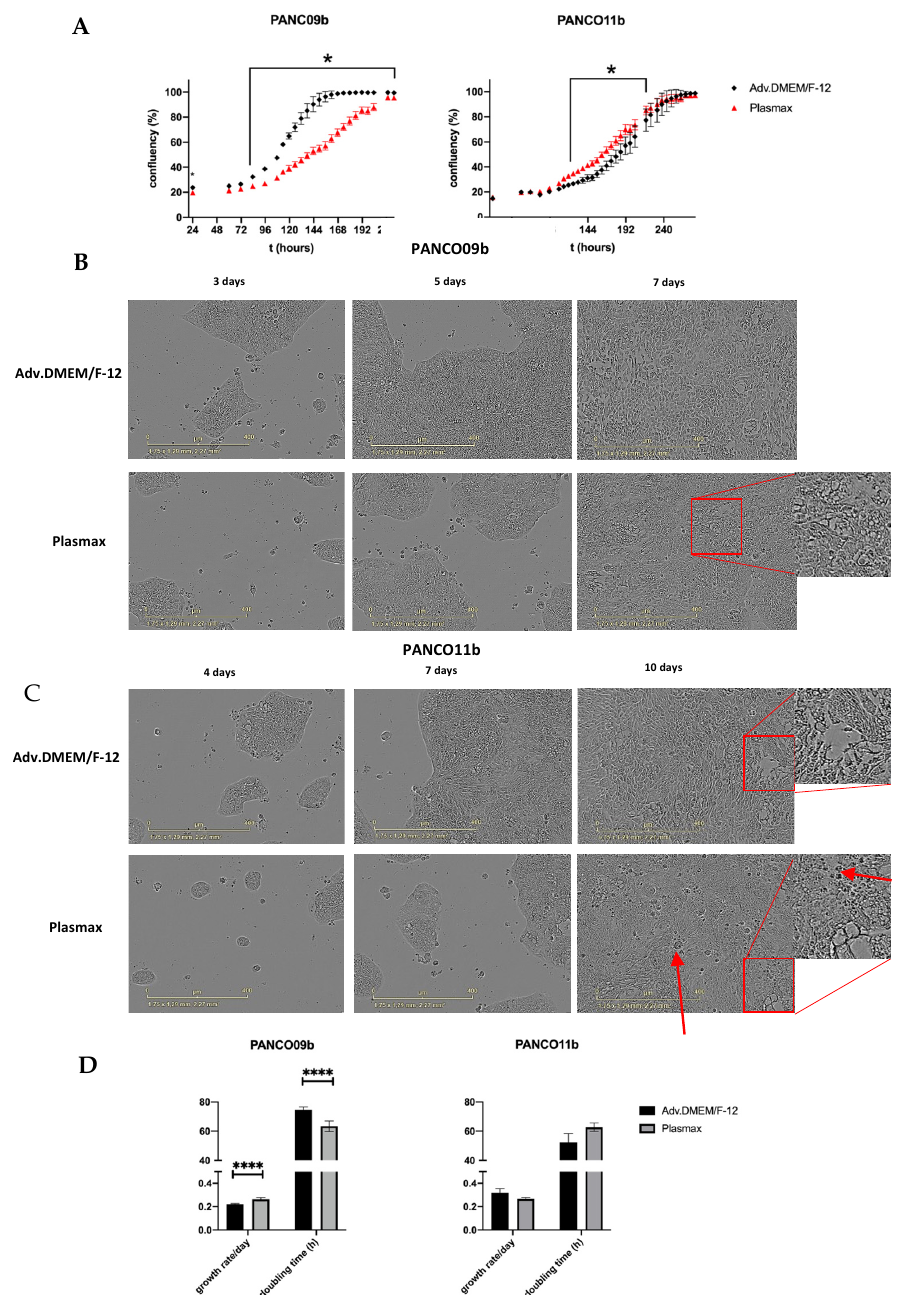
Figure 3. Characteristics of PANCO09b and PANCO11b cells grown in 2D in adv.DMEM/F-12 versus Plasmax. ( A ): Growth curves of 2D cultured PANCO09b and PANCO11b grown in adv.DMEM/F-12 or Plasmax medium. Images were taken every 2 h by Sartorius Incucyte S3 (not all data points shown). First shown data point is 24 h due to attaching of the cells to the surface of the plate. Data are presented as mean ± SD of one experiment performed with 6 replicates. Two-way ANOVA with Sidak’s correction for multiple comparisons was performed to analyze the effect of media over time. ( B ): Images of 2D cultured PANCO09b grown in adv.DMEM/F-12 or Plasmax after 3, 5, and 7 days. ( C ): Images of 2D cultured PANCO11b grown in adv.DMEM/F-12 or Plasmax after 4, 7, and 10 days. Images were taken by Sartorius Incucyte S3 at 10× magnification. ( D ): Doubling time in hours and growth rate/day of 2D cultured PANCO09b and PANCO11b grown in adv.DMEM/-F-12 and Plasmax. Data are presented as mean ± SD of three independent experiments performed in triplicate. Independent sample t-test was performed to assess differences. * = p < 0.05, **** = p <